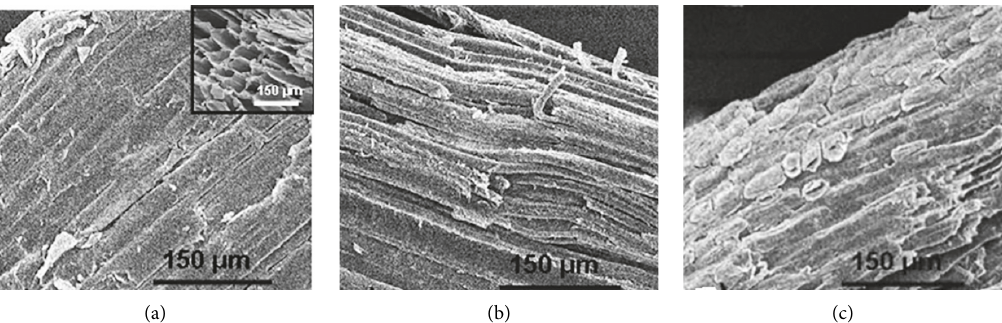
Figure 9: SEM micrographs of bagasse fiber: (a) untreated fiber; (b) fibers treated with alkyltrialkoxysilane; (c) fibers treated with dia- lkyldialkoxysilane [124]. Reproduced with permission from